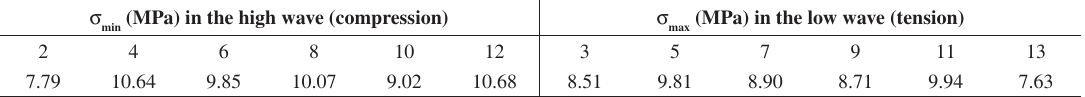
Figure 15. Stresses in the model with span of 1830 mm: (a) Maximum value of tension ( σ (b) Maximum value of compression ( σ ) in the upper surface of the high min Table 2. Values of maximum longitudinal stresses in the model with span of 1100 mm.